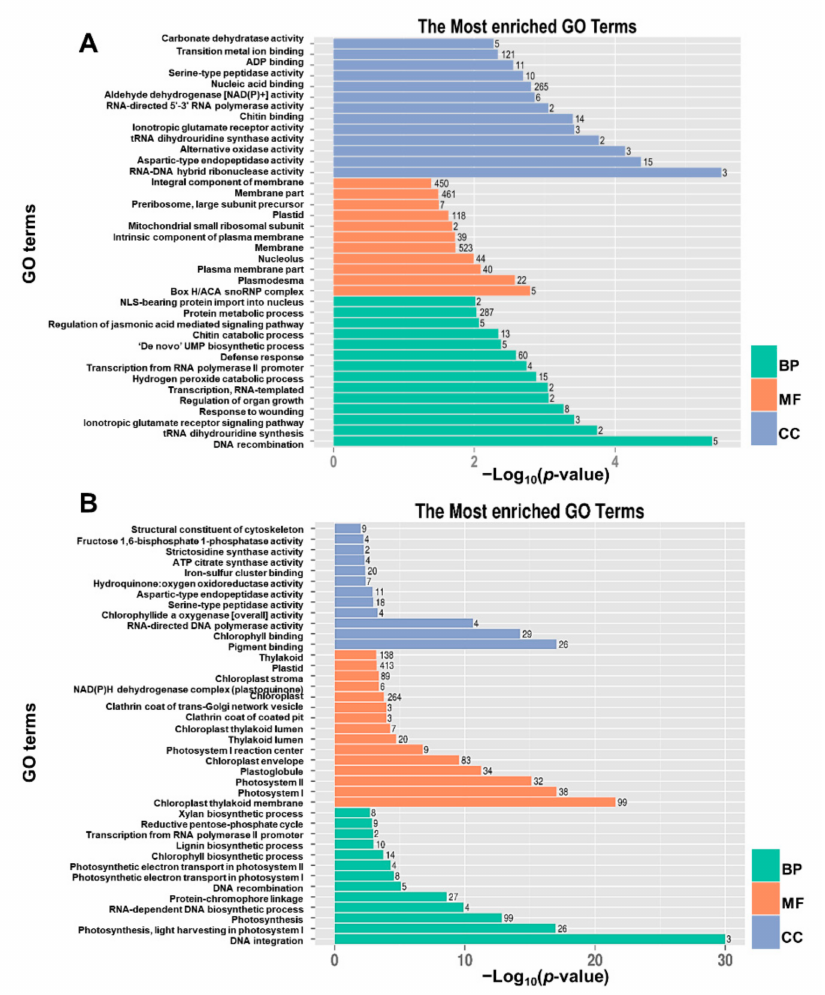
Figure 11. The significantly enriched GO terms of the up-regulated and down-regulated DEGs between dnl2 and the wild-type. ( A ) The enriched BP, MF, and CC terms of the up-regulated DEGs. ( B ) The enriched BP, MF, and CC terms of the down-regulated